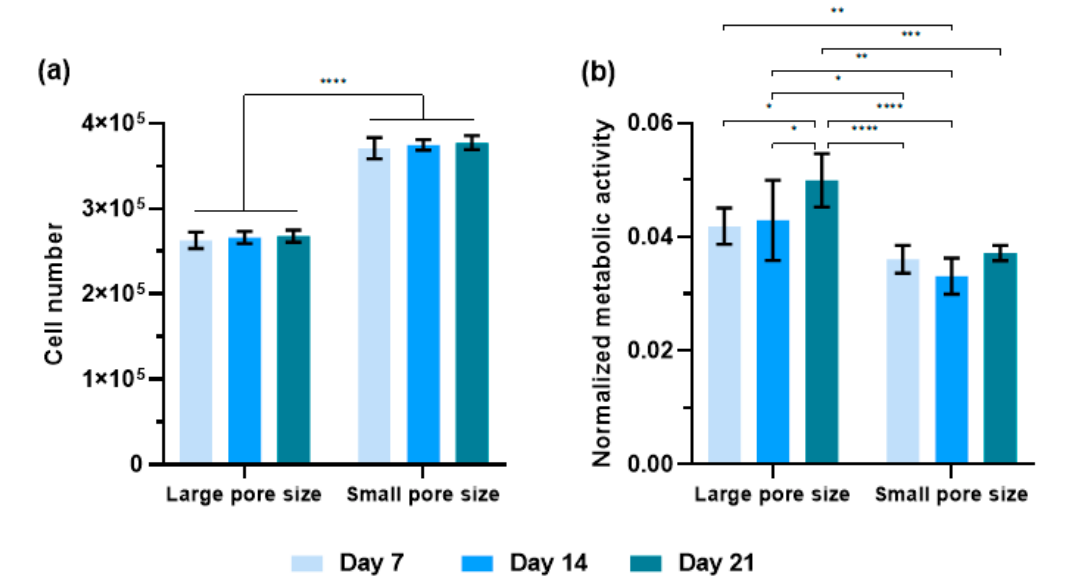
Figure 4. ( a ) Cell proliferation and ( b ) Metabolic activity of hMSCs in 7 days, 14 days, and 21 days of cell culture. n = 8; * p < 0.05; ** p < 0.01; *** p < 0.001; **** p < 0.0001.